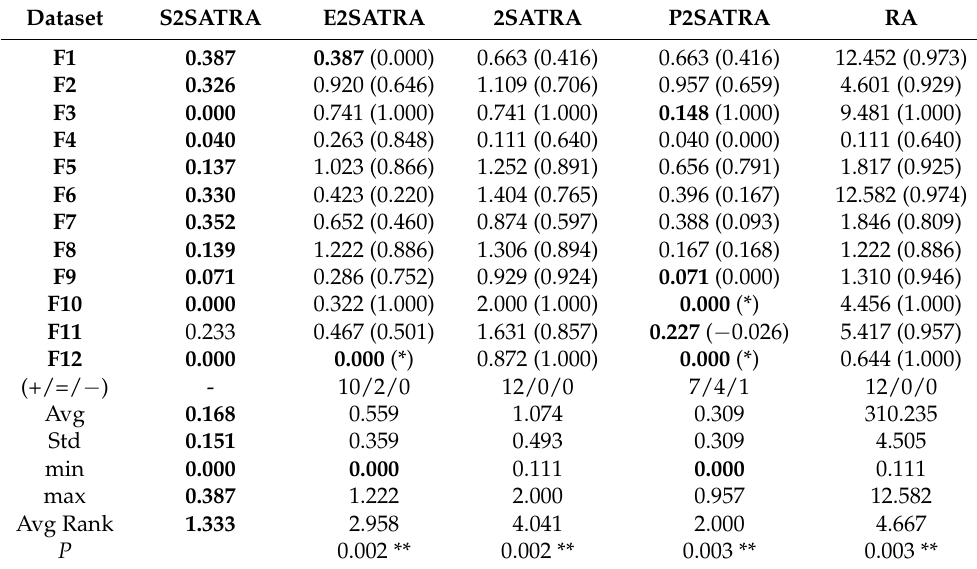
Table 10. MAE for all logic mining models. The bracket indicates the ratio of improvement and * indicates division by zero. A negative ratio implies the method outperform the proposed method. P is obtained from the paired Wilcoxon rank test and ** indicates the model with significant inferiority compared to the superiority